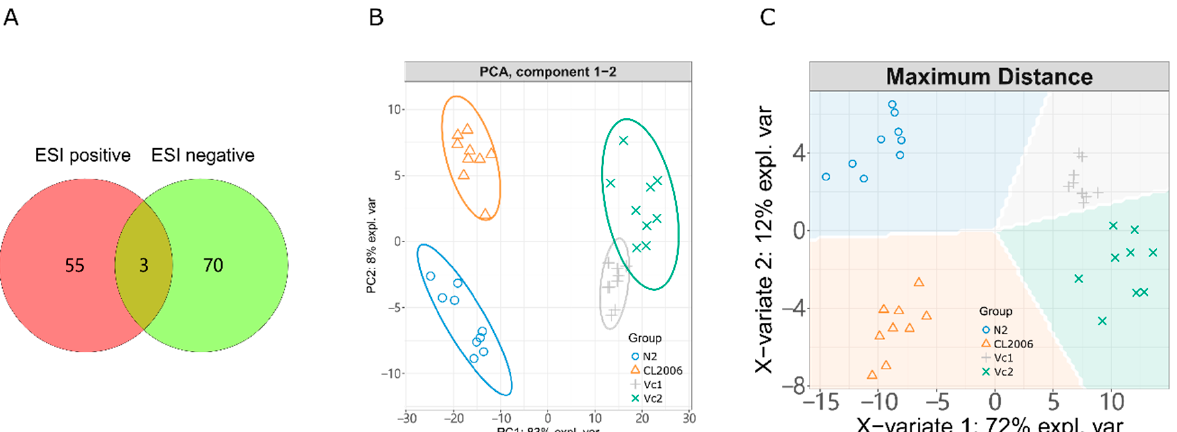
Figure 2. ( A ) the number of identified metabolites based on ESI positive and negative fragments. Detailed information on the identified metabolites can be found in Table S1 in the supplementary materials. ( B ) PCA and ( C ) sPLS-DA analysis.